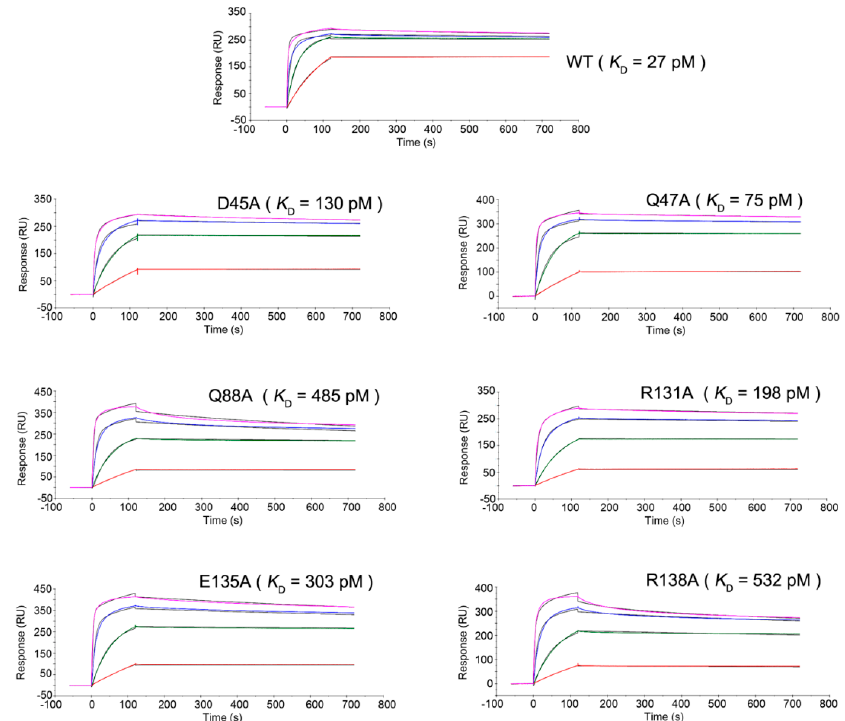
Figure 4. Sensorgrams for the binding kinetics of the TNF α mutants. Surface plasmon resonance analyses of wild-type and mutant TNF α , demonstrating their binding affinities to certolizumab Fab fragments. The concentrations of the wild-type and mutant TNF α for each experiment are 2 (red), 10 (green), 50 (blue), 250 nM (purple).